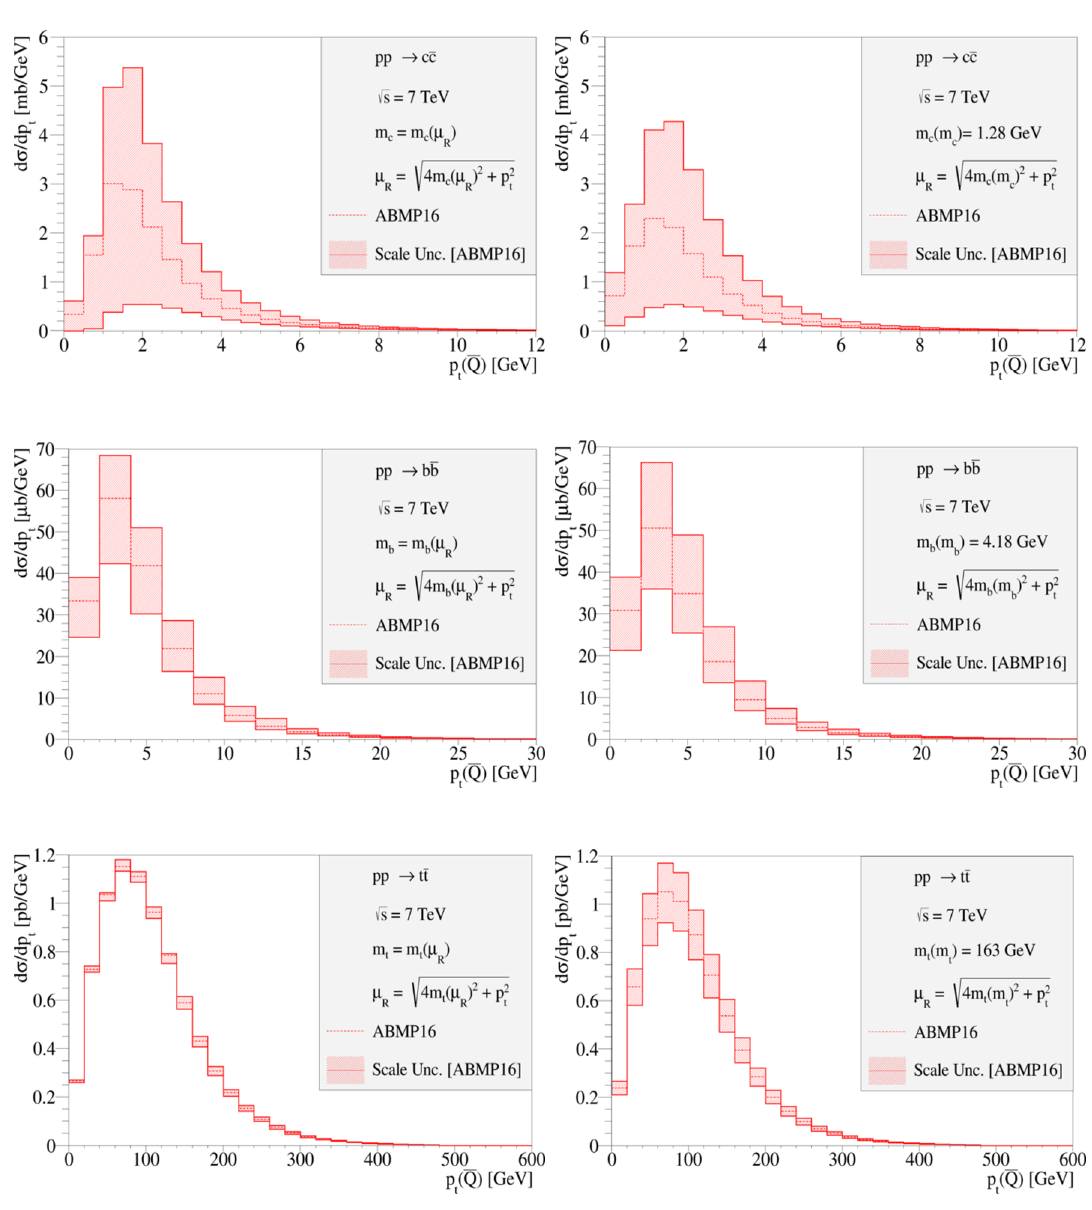
√ s = 7 TeV) for charm (upper panels), q p 2 + 4 m 2 ( µ m ) and different mass T Q